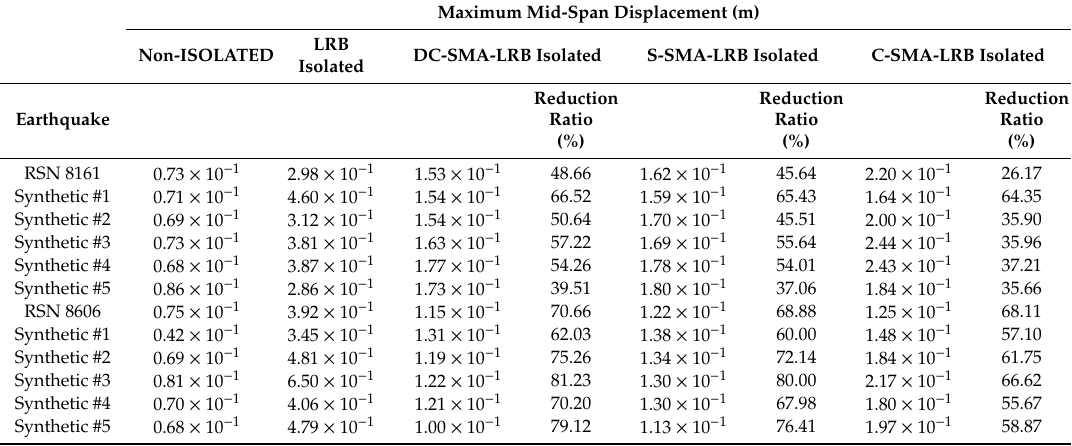
Figure 15. Graphical demonstration of the maximum mid-span displacement for the non-isolated, LRB-isolated and the three SMA-LRB isolated bridges. Table 6. Maximum mid-span displacement for the non-isolated, LRB-isolated and three SMA-LRB isolated bridges.